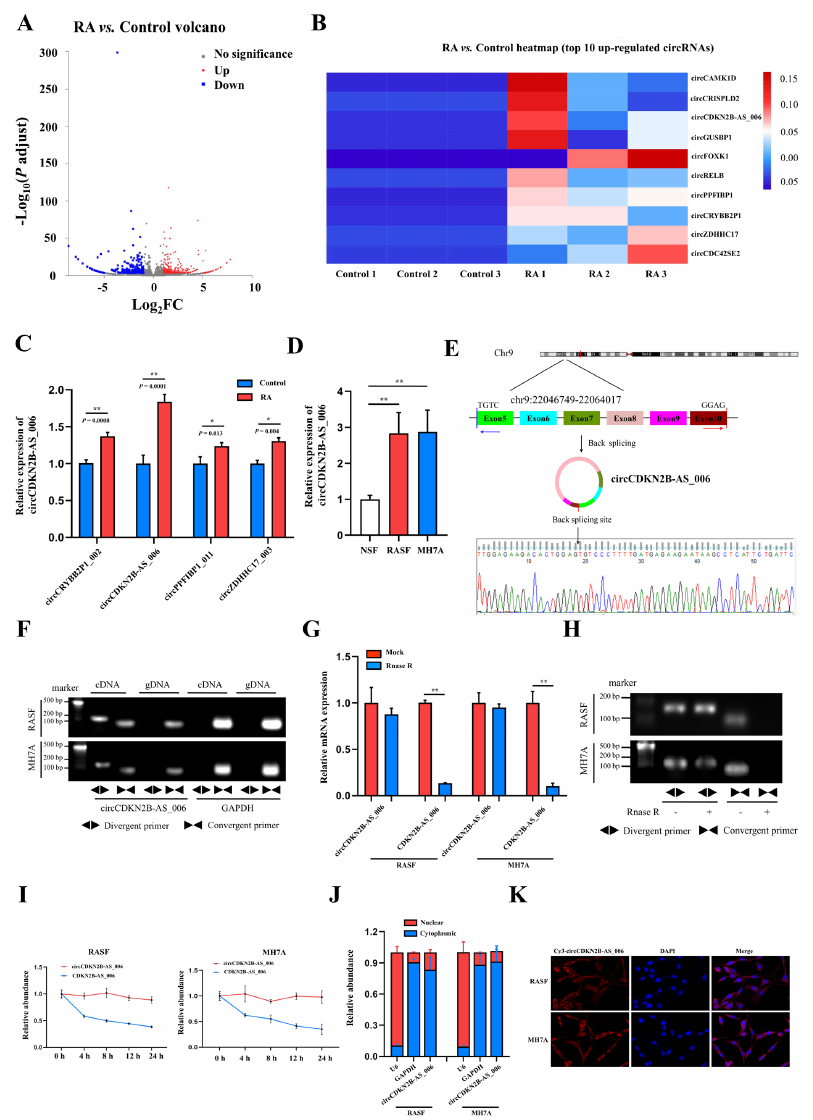
Figure 1. Identification and characterization of circCDKN2B − AS_006. ( A ) Volcano plots showing 283 upregulated and 256 downregulated circRNAs in the synovia from RA patients relative to pa- tients with joint trauma. ( B ) The top 10 upregulated circRNAs. ( C ) Relative circCRYBB2P1_002, circCDKN2B − AS_006, circPPFIBP1_011, and circZDHHC17_003 expressions in the synovia from RA patients ( n = 40) and patients with joint trauma ( n = 16) were detected by RT − qPCR. ( D ) Relative circCDKN2B − AS_006 expression in RASFs, MH7A cells, and NSFs was determined via RT − qPCR. ( E ) The schematic illustration showed the back − splicing of circCDKN2B − AS_006, and Sanger se- quencing validated the splicing site. ( F ) RT − PCR with divergent and convergent primers and agarose gel electrophoresis analysis were performed to detect the presence of circCDKN2B − AS_006 and its maternal gene CDKN2B − AS_006 in cDNA and gDNA samples from RASFs and MH7A cells. ( G , H ) CircCDKN2B − AS_006 and linear CDKN2B − AS_006 expression in RASFs and MH7A cells were detected by means of RT − qPCR ( G ) and RT − PCR ( H ) after treatment with RNase R or mocks. ( I ) RT − qPCR analysis of the circCDKN2B − AS_006 and CDKN2B − AS_006 expression in RASFs and MH7A cells under treatment with actinomycin D. ( J ) CirCDKN2B − AS_006 was predominantly local- ized to the cytoplasm of RASFs and MH7A cells, as indicated by a nuclear − cytoplasmic fractionation assay. GAPDH and U6 functioned as normalizing cytoplasmic and nuclear controls, respectively. ( K ) Representative FISH images showing the cellular localization of circCDKN2B − AS_006. ** p <